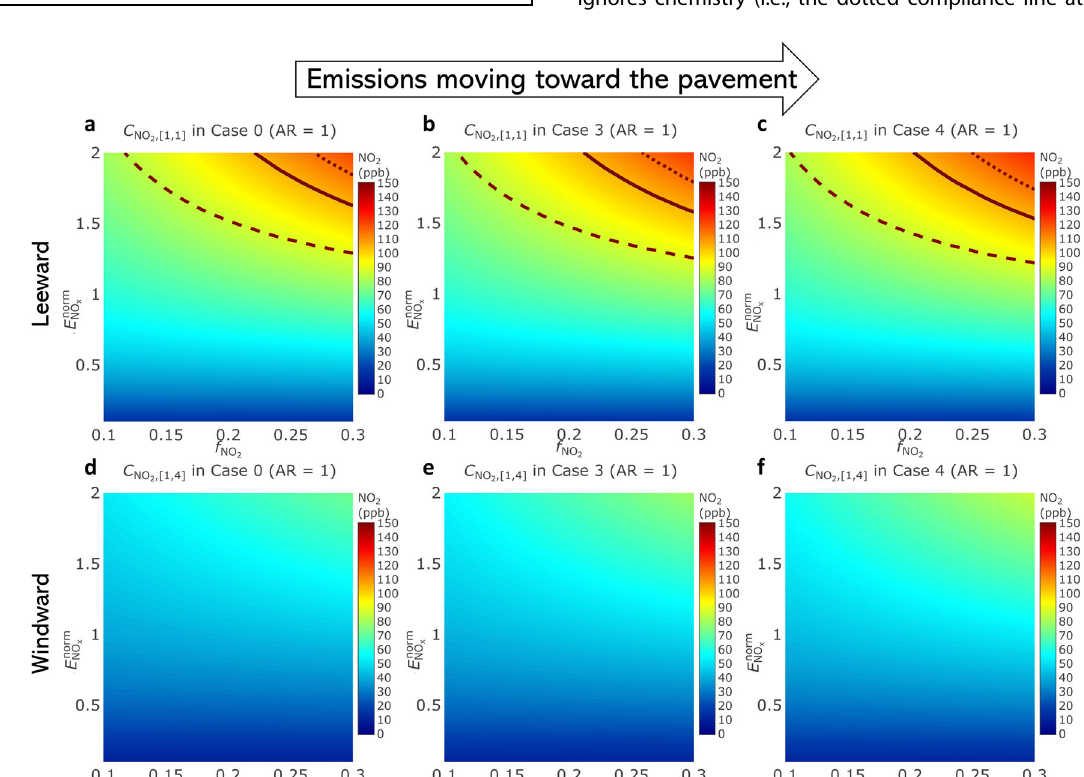
Fig. 2 Emission heterogeneities on NO 2 mixing-ratios in the regular canyon. The mixing-ratios (ppb) of NO 2 on the leeward side ( C NO , [1,1] ) 2 ¼ 1 under different emission heterogeneities. f ) of the regular canyon at E norm and windward side ( C NO NO 2 is the primary NO 2 fraction, and VOCs 2 ,[1,4] E norm is the ratio of NO x emission rates to the TEC of a typical emission condition. The solid line represents the UK air quality hourly NO 2 limit NO x changes to 0.1 and 2, (105 ppb), and this contour line shifts to the dotted and dashed lines when E norm VOCs